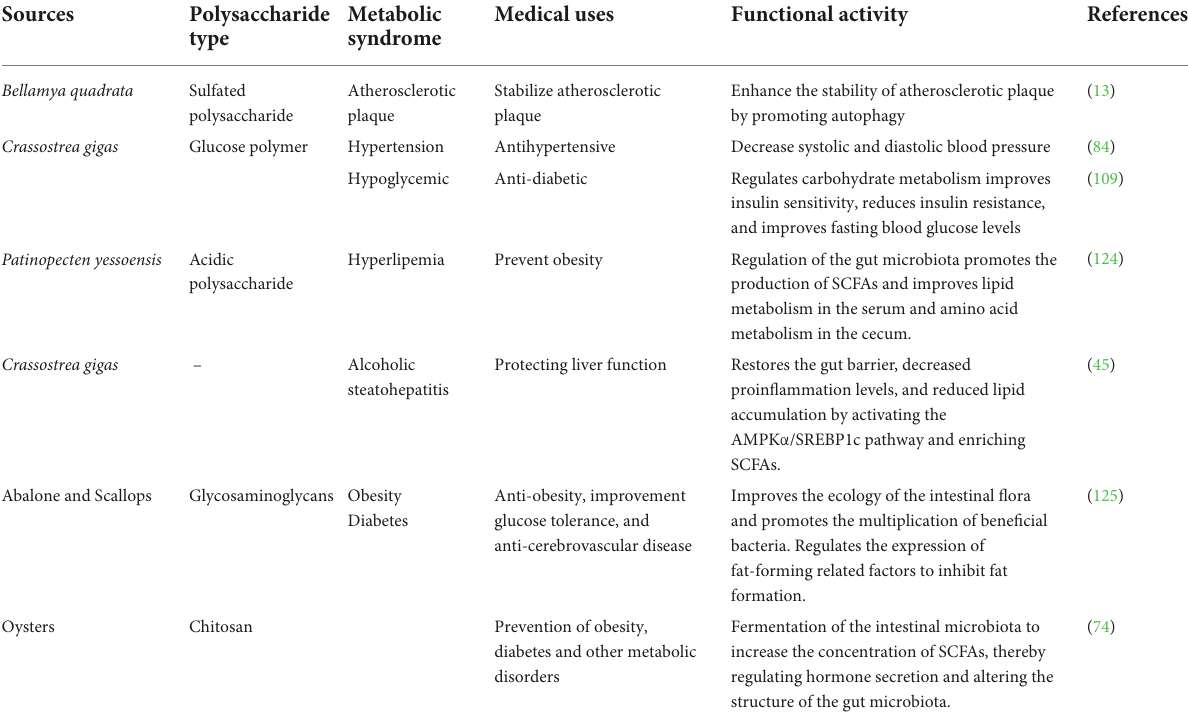
TABLE 1 Shellfish polysaccharides improve the functional activity of